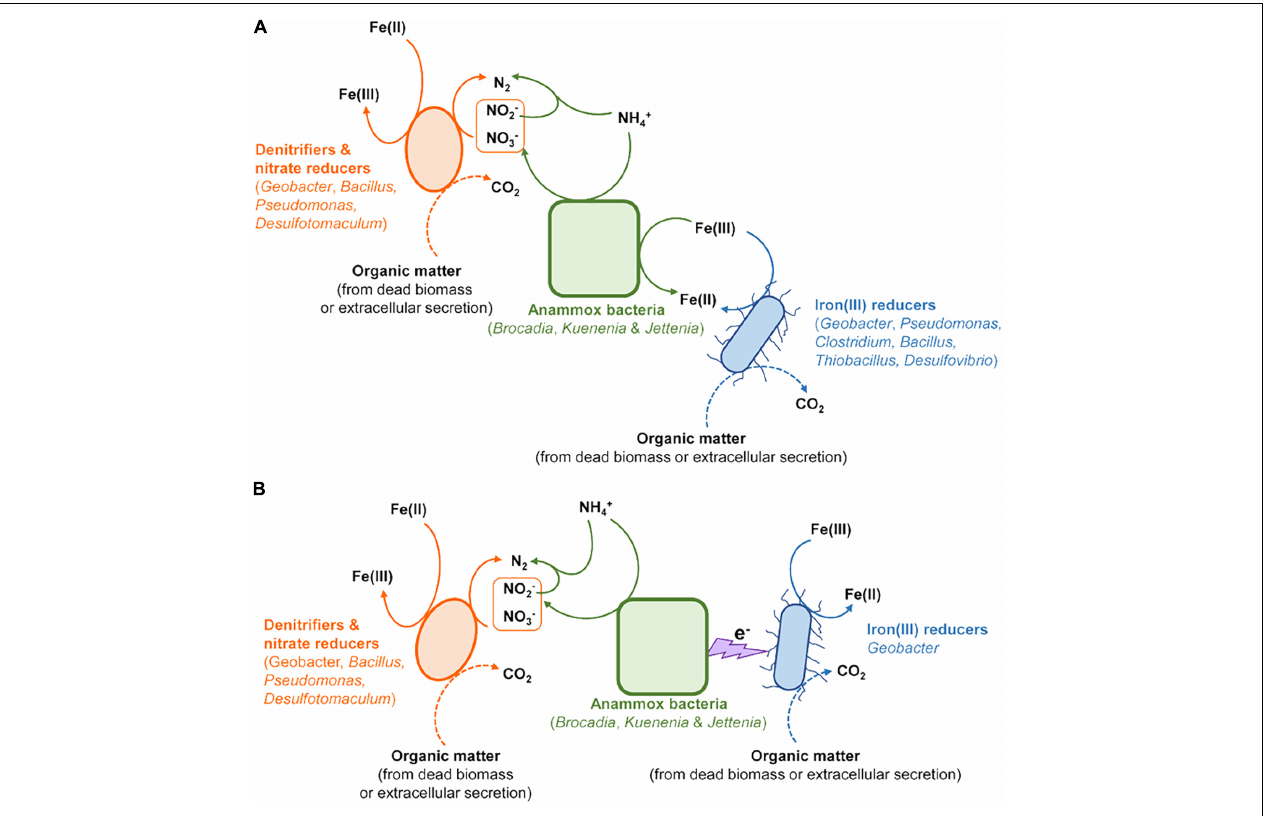
FIGURE 5 | The potential models of microorganisms contributing to N removal via Feammox. (A) Anammox bacteria directly involved in the Feammox-associated N removal. (B) Interaction between Anammox bacteria and Geobacter linked to Feammox-associated N